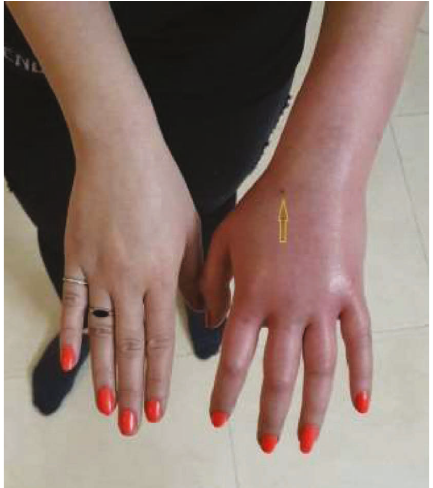
Figure 2: Arrows show inflammation, swelling, and redness in the metacarpal of the left